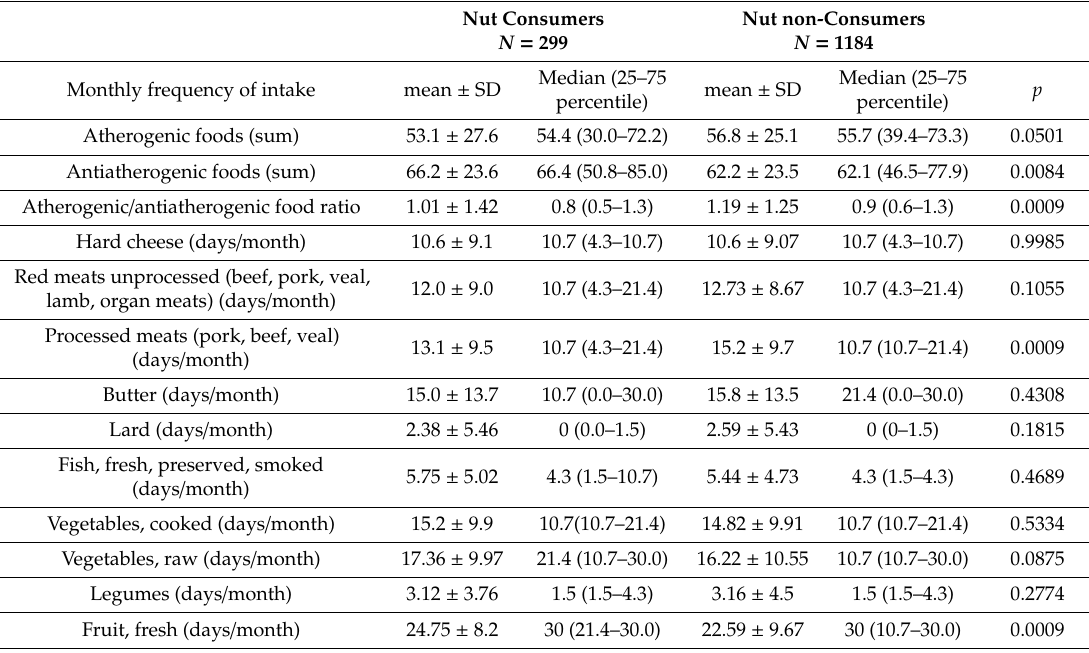
Table 3. Frequency of consumption (according to number of days a month) of atherogenic and antiatherogenic food